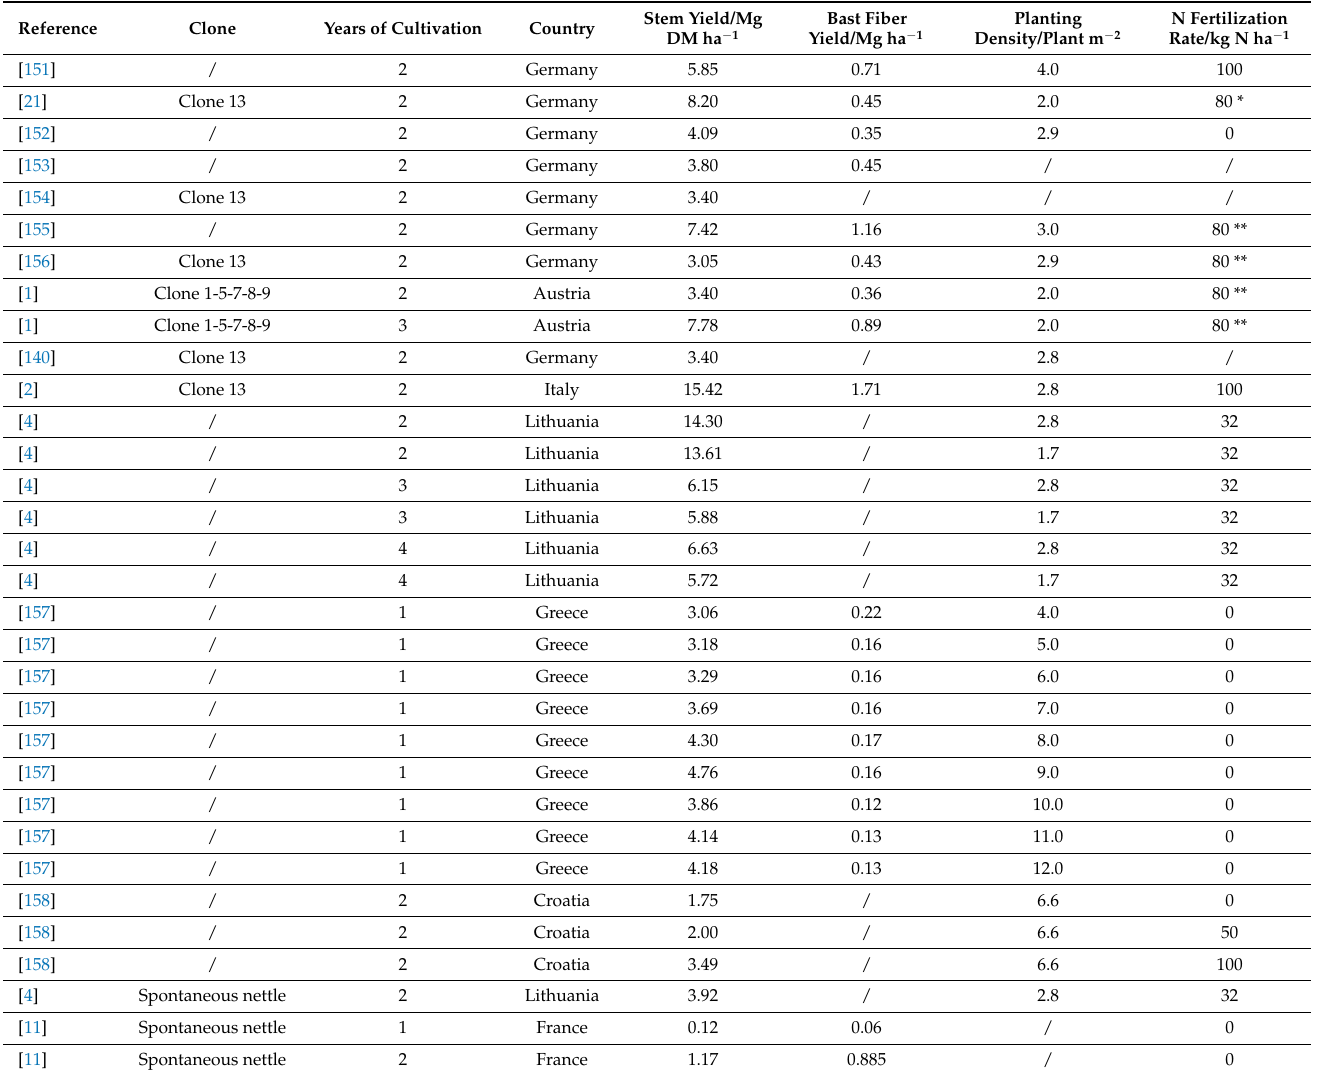
Table 2. Summary of data for the studies collected in the literature relative to nettle stem and bast fiber yield (Mg DM ha − 1 ) as affected by years of cultivation and agronomic practices (planting density and N fertilization